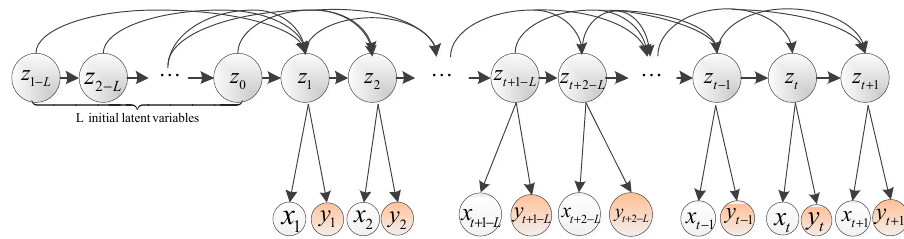
Figure 1. Probability graph model of dynamic autoregressive latent variable model.